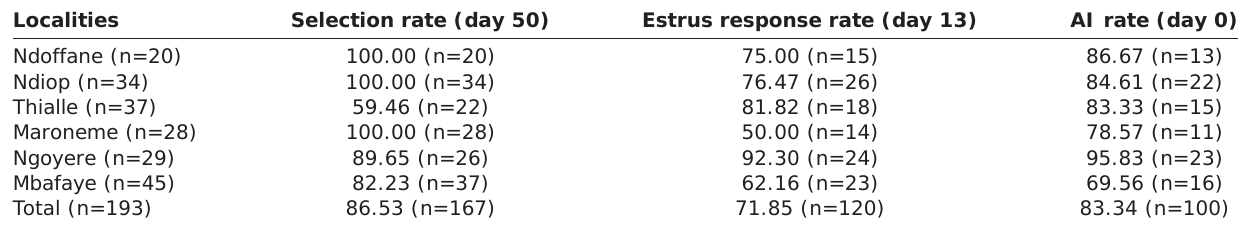
Table-1: Ultrasonographic results of selection, estrus response and AI. Localities